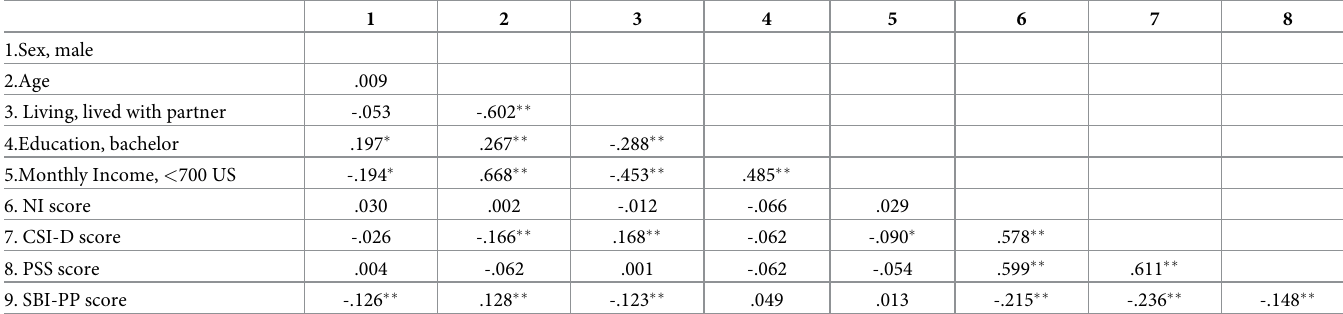
Table 2. Correlation matrix among